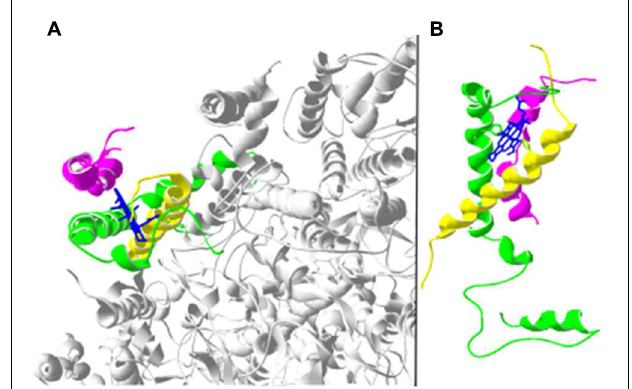
FIGURE 1 | Structure of the PSII complex from T. vulcanus (Pdb id: 4il6 [3]) generated by Swiss-pdb viewer program. (A) Overview of PSII in the Cyt b 559 area. Low molecular mass proteins: PsbE (green), PsbF (yellow) and PsbY (magenta). The heme group is shown in blue and PSII core in gray. (B) Close-up of PsbE, PsbF, and PsbY proteins showing ligands and the